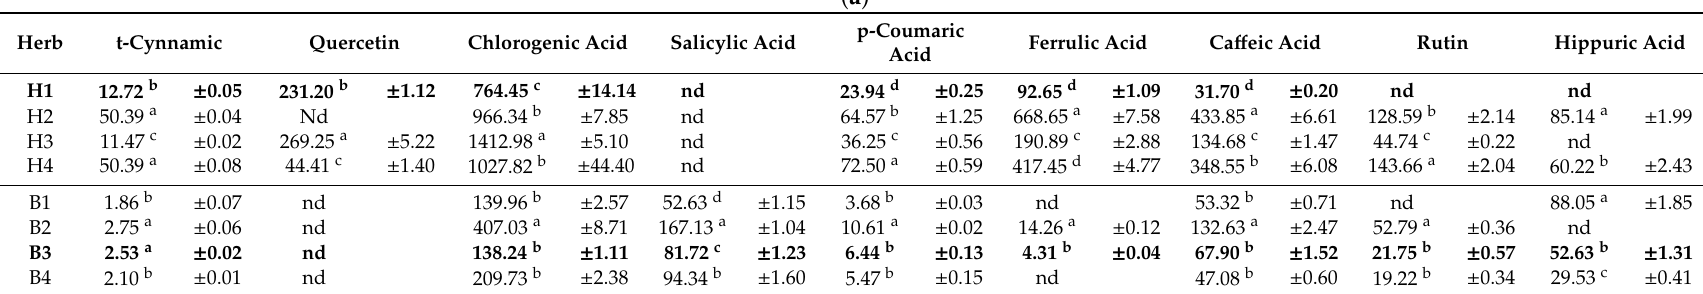
Table 6. ( a ) Phenolic profile of herbs from di ff erent retailers (mg / 100g) (mean values ± standard errors (SE). ( b ) Phenolic profile of meat samples during storage (mg / 100g) (mean values ± standard errors